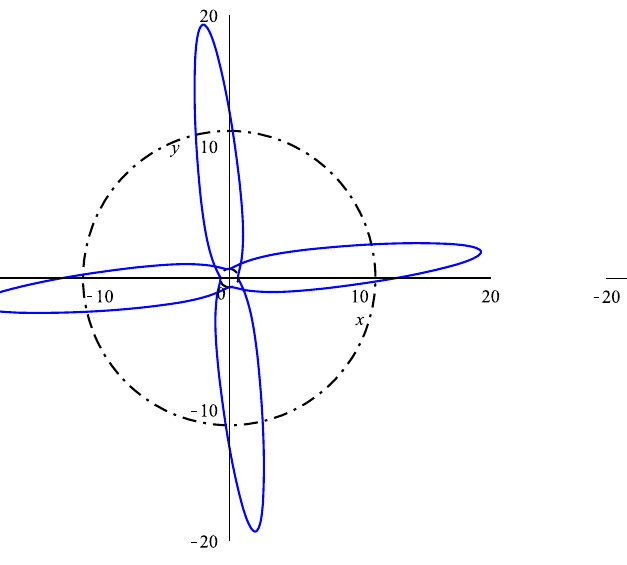
(a) Many-world bound orbit in region (2) with E 2 = 10 and L − 2 = 0 . 005 Fig. 3 Null geodesic in the charged BTZ black hole with (cid:4) = − 0 . 1, m 0 = 2, q = 1 . 5 and r 0 = 1 . 08. The dash dotted lines represent the horizons This results in the same inequality (32) as for the case of massive particles which indicates absence of an event hori-